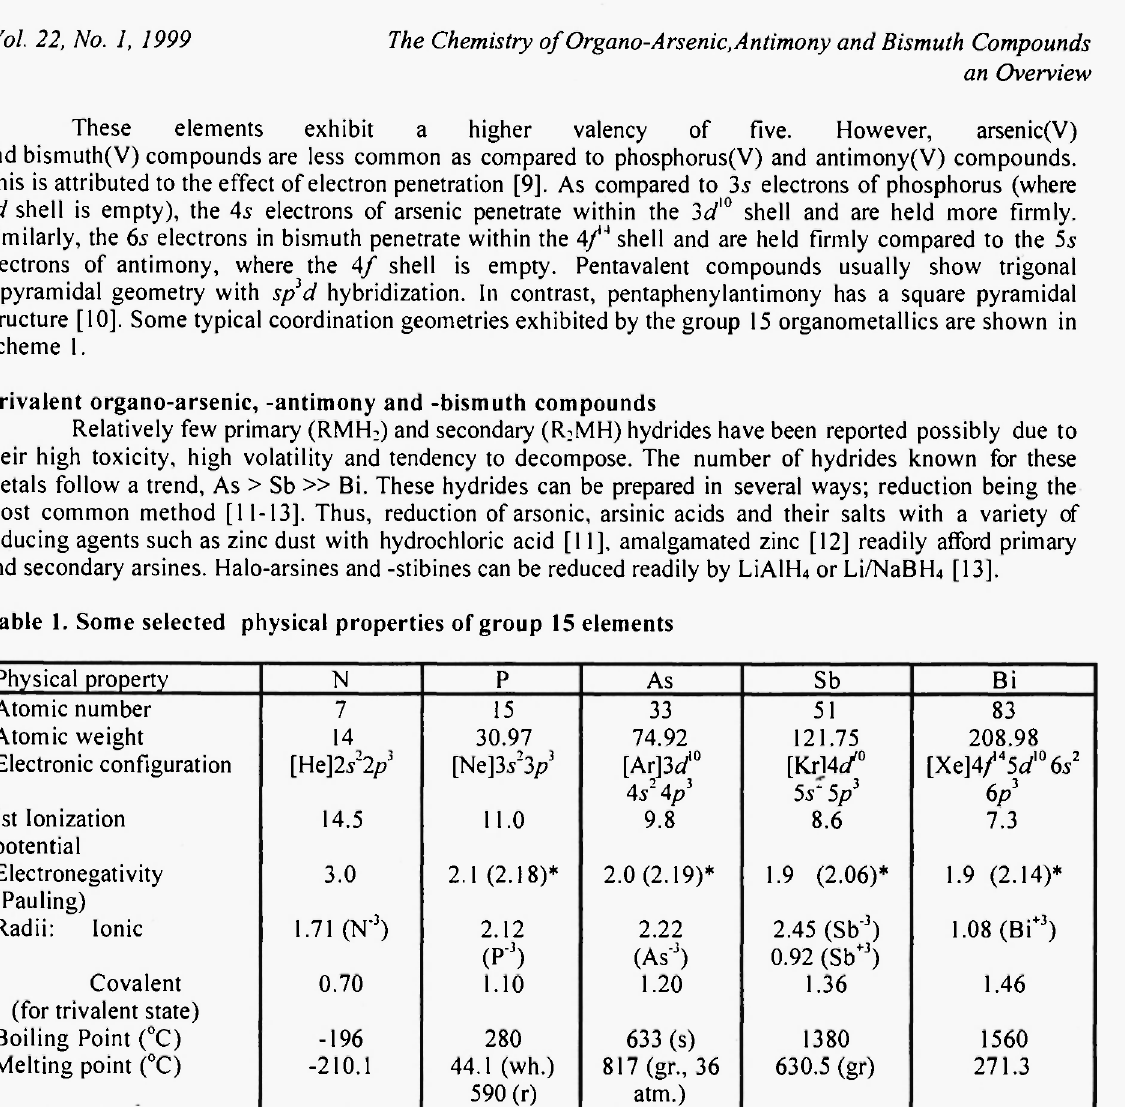
Abudance in earth's